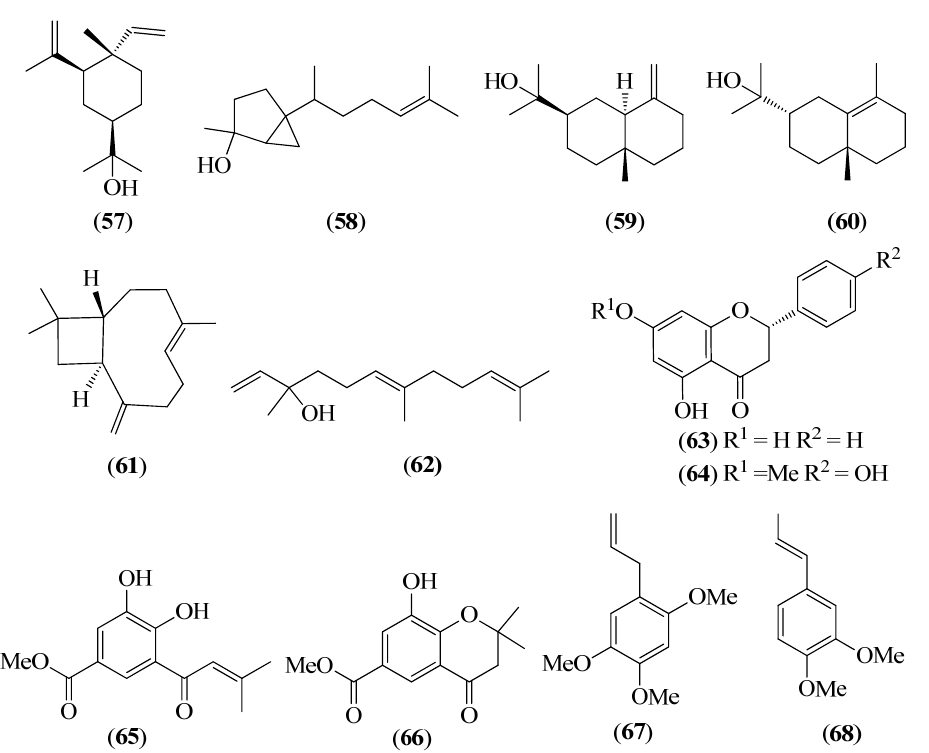
Figure 8. Structures of compounds 46 – 50 from Huperzia compacta , H. columnaris , and H. tetragona ; 51 and 52 from H. brevifolia and H. espinosana ; and 53 – 56 from H. crassa .